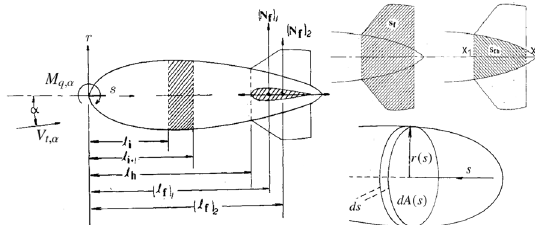
Fig. 2 Schematic of an Airship